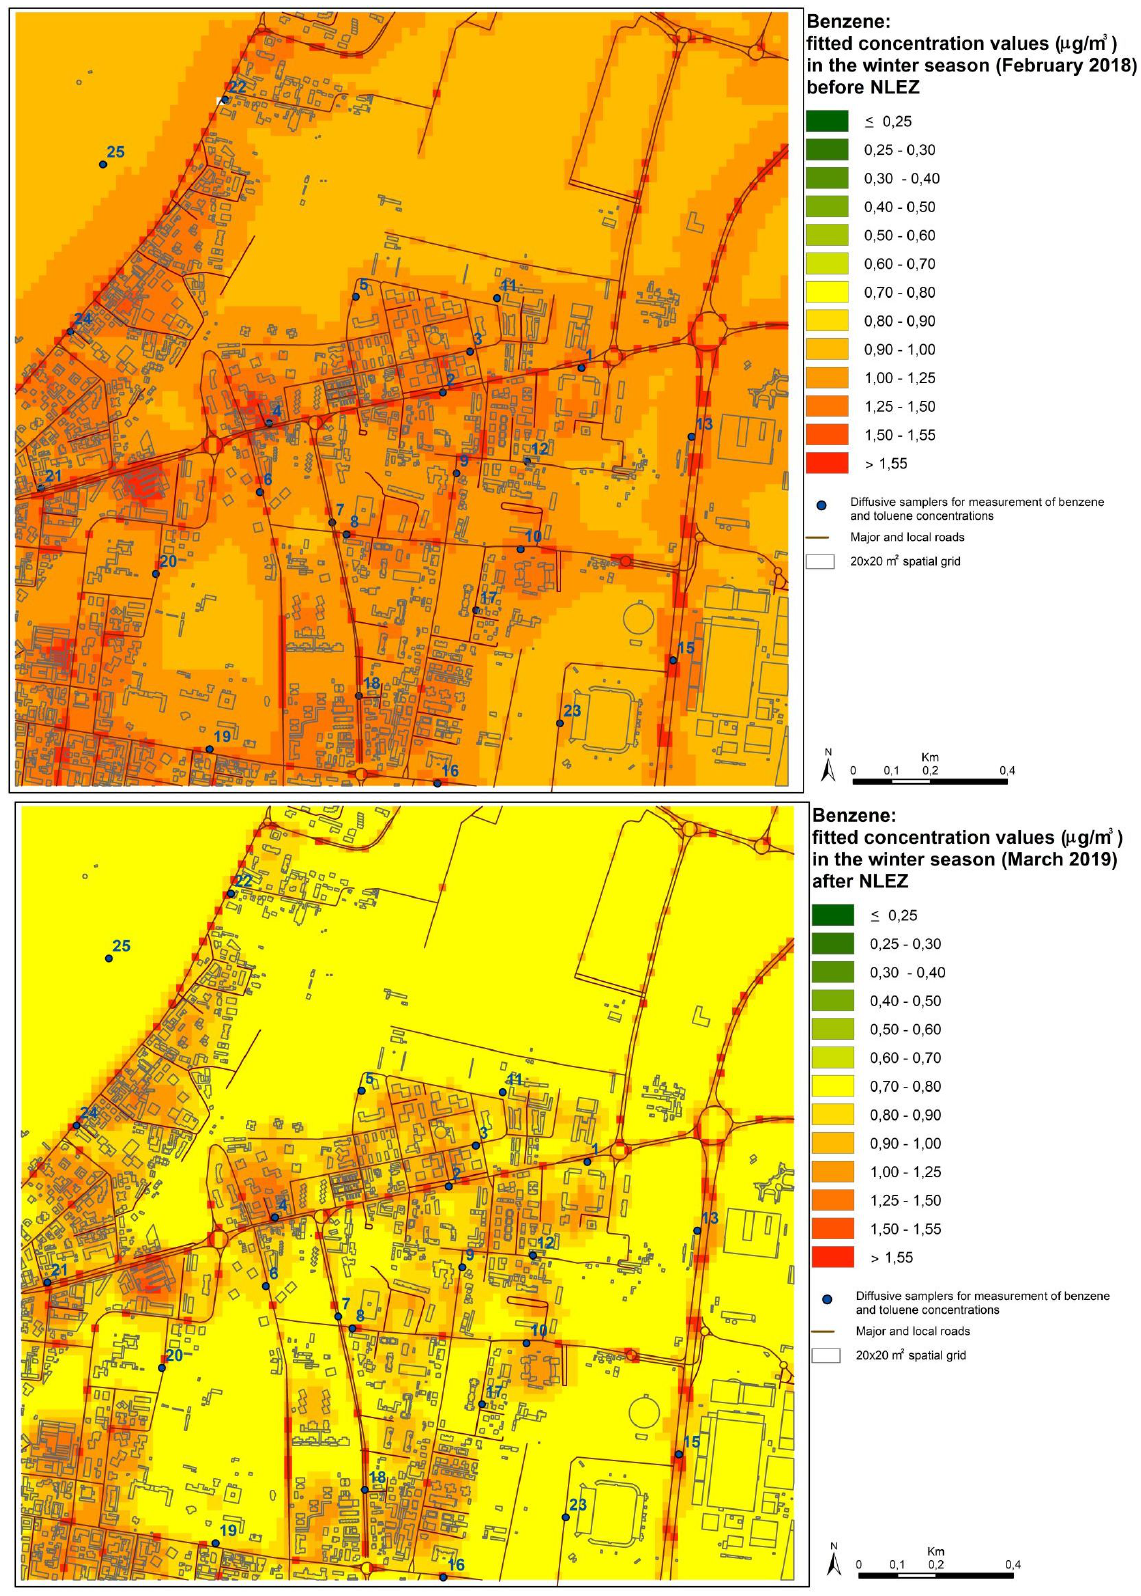
Figure 15: Benzene winter concentration levels ( µ g/m 3 ) estimated from GAM models before (left) and after (right) Noise LEZ